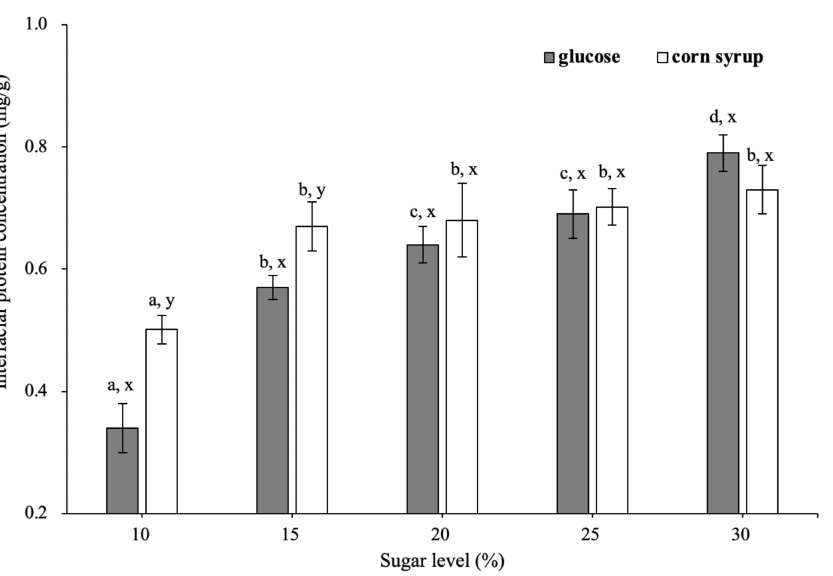
Figure 2. Interfacial protein concentration of the emulsions at different sugar concentrations. Different letters of a–d on the top of columns represent significant differences ( p < 0.05) among the various sugar levels. Different letters of x, y on the top of columns represent significant difference ( p < 0.05) between glucose and corn syrup at the same